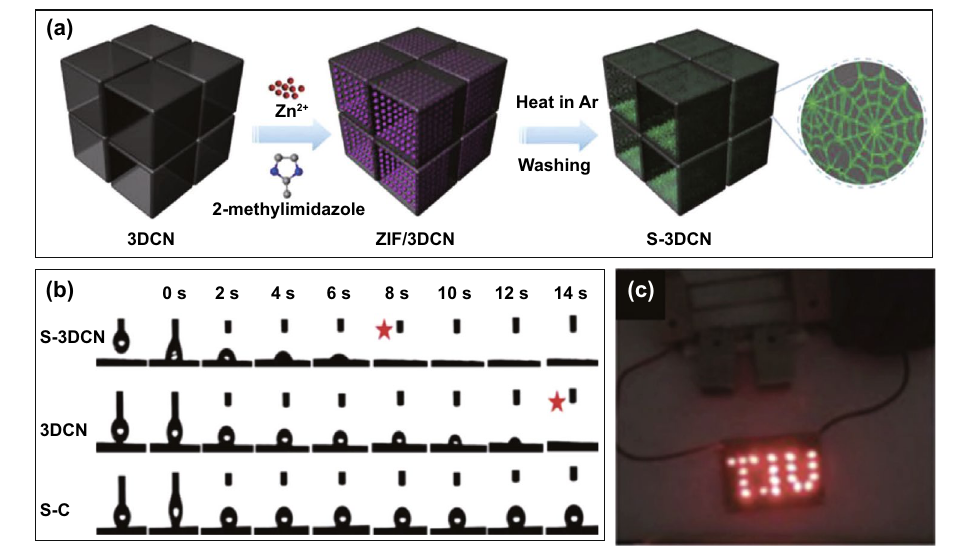
Fig. 3 a The illustrated scheme of the synthesis process, b The results of water-drop experiments of S-3DCN, 3DCN, and S-C, and c LED light devices powered by three supercapacitors connected in series. Reproduced with permission from Ref. [110]. Copyright 2018 Elsevier